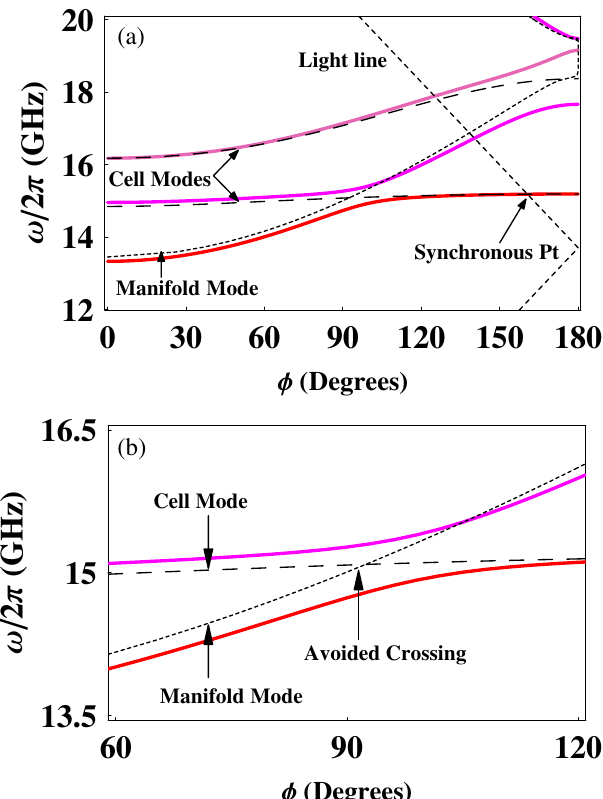
FIG. 3. (Color) (a) Brillouin diagram for cell 27 of a 55-cell structure. The dashed curves represent the dispersion curves for the modes prior to coupling to the manifold. Also illustrated is the light line and the point at which it intersects the cell mode (in which the beam is synchronous with the dipole mode). (b) Expanded view of the characteristic manner in which the mani- fold mode and the cell mode avoid crossing due to the coupling of the modes. The strength of the coupling is proportional to the minimum degree of separation of the coupled